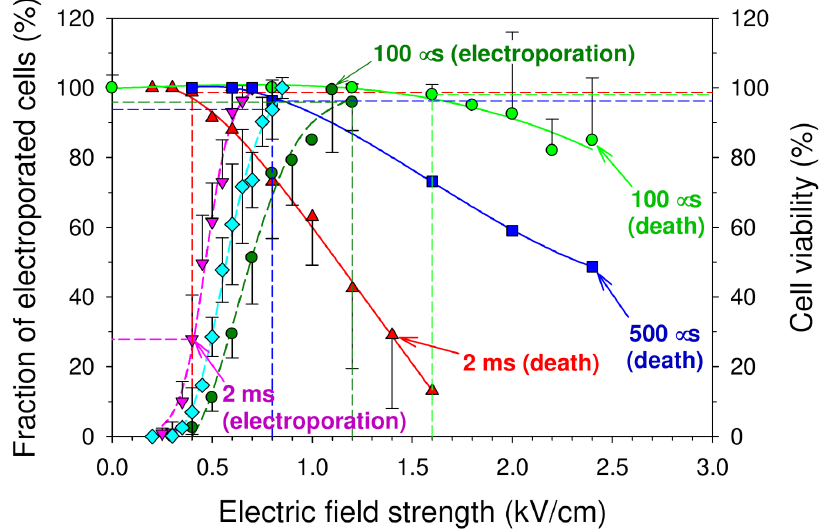
Figure 1. The dependence of the fractions of electroporated (left ordinate) and viable (right ordinate) mouse hepatoma MH-22A cells on the electric field strength of a single square-wave pulse. These dependences are shown for pulses with a duration of 100 µ s, 500 µ s, and 2 ms. The fraction of electroporated cells was estimated from the increase of the permeability of the cell plasma membrane to intracellular potassium ions [47]. The viability of the cells treated with electric pulses was evaluated by a colony-forming efficiency assay, and it was calculated as the percentage of the colonies obtained from the untreated control cells. The data for pulses with the duration of 100 µ s and 2 ms were taken from Saulis and Saule [53]. Experimental points are averages from 3–4 experiments ±